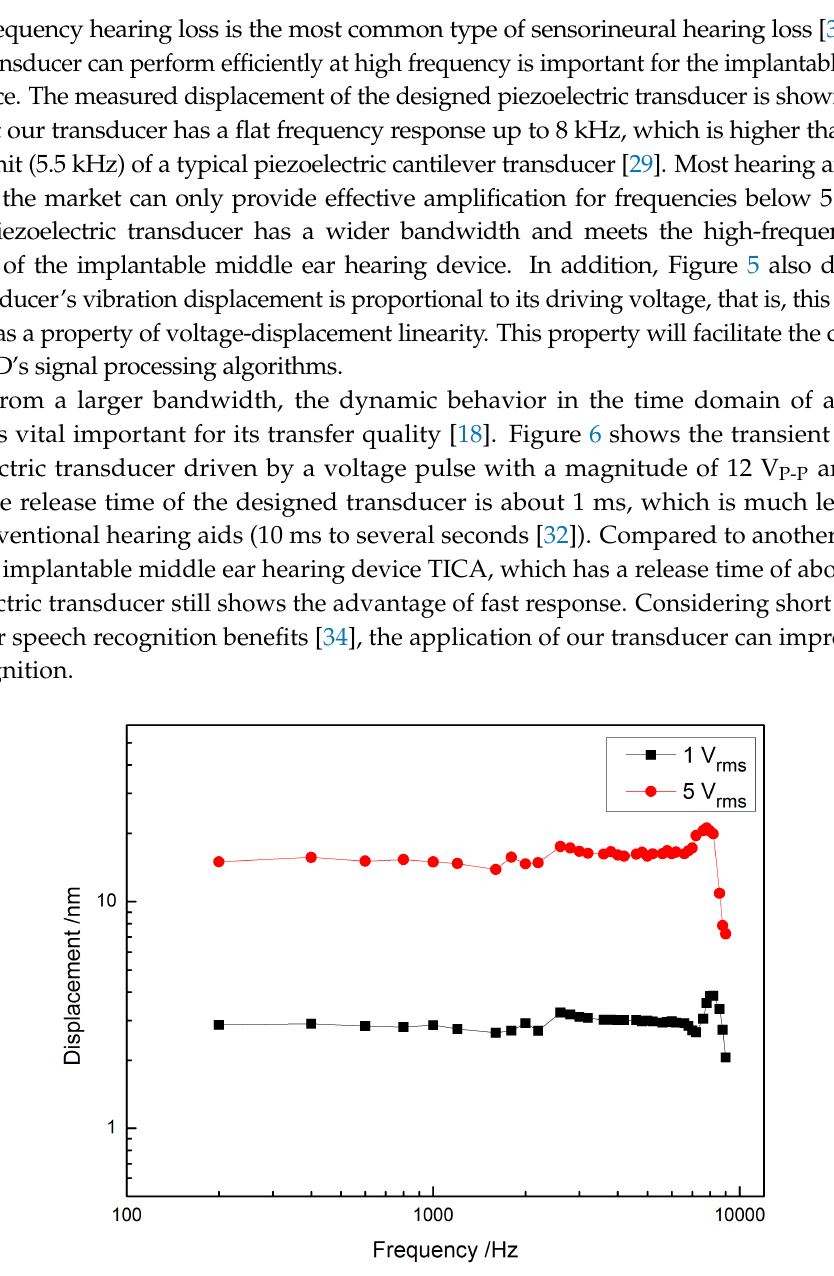
Figure 5. Frequency response of the piezoelectric transducer vibration at two applied voltage levels.